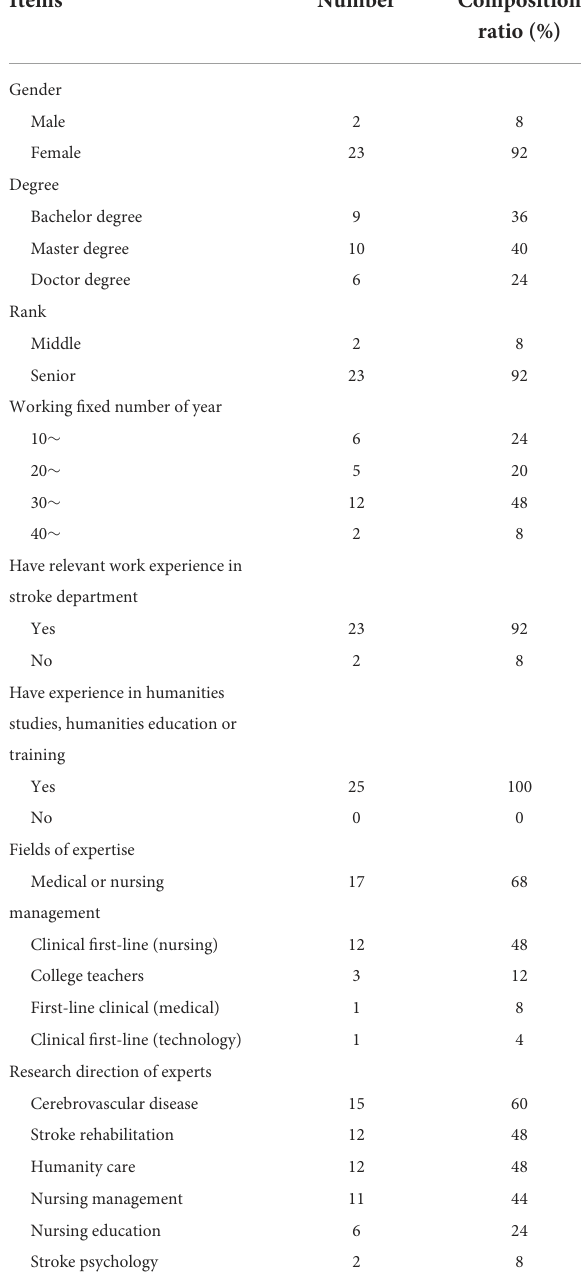
TABLE 1 General information of experts ( n =